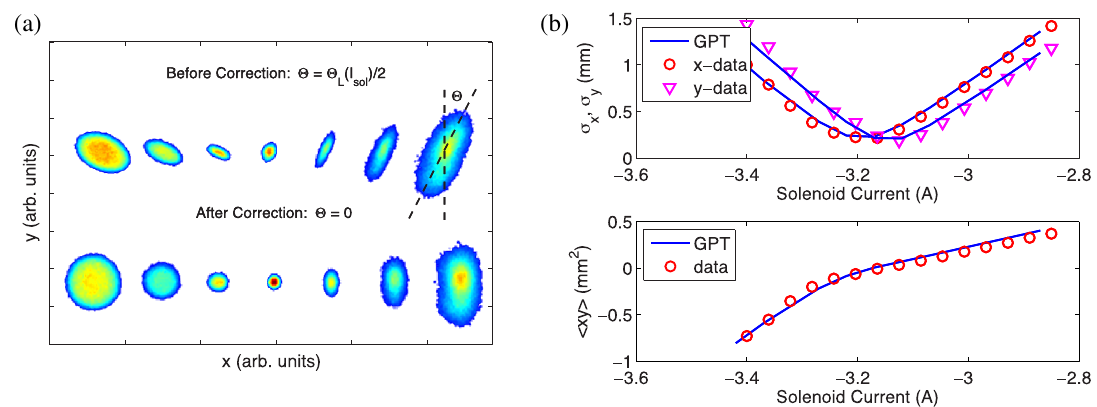
FIG. 4. Characterization and correction of the quadrupole moment in the first solenoid. (a) Elliptical beam spot on the first viewscreen after the first solenoid. The tilt of the ellipse was exactly half the Larmor angle of the solenoid. (b) Fitting the measured second moments of the beam spot on the first viewscreen to GPT to estimate the quad